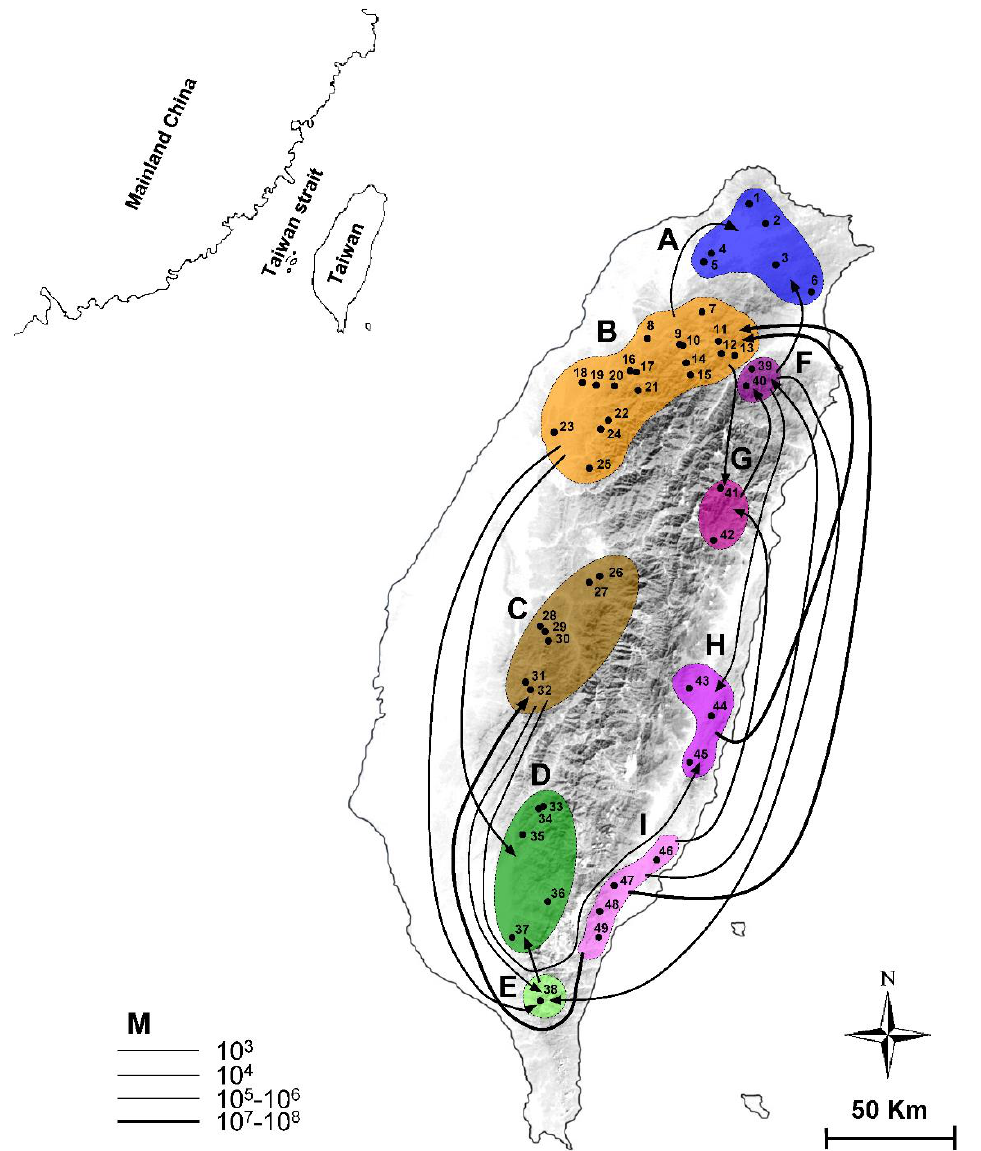
Figure 6. Dispersal inferences on the current demographic patterns for the hilly lineage of NSC by using COI + 16S rRNA genes. Nine populations were tentatively defined based on the topography of Taiwan Island. The migration rate ( M ) is shown by lines of different thicknesses at the bottom left. Table 6. Frequency of dispersal inference estimated through COI + 16S rRNA genes